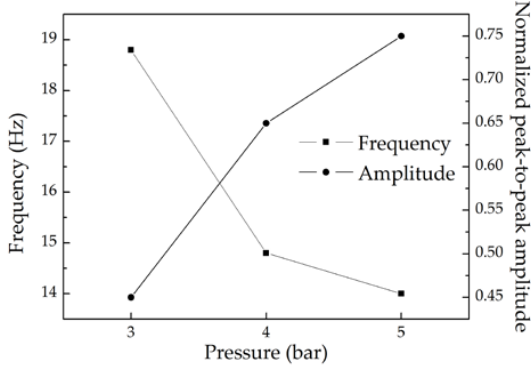
Figure 8. Pulsation frequency and amplitude of flame heat-release rate for combustor pressure.